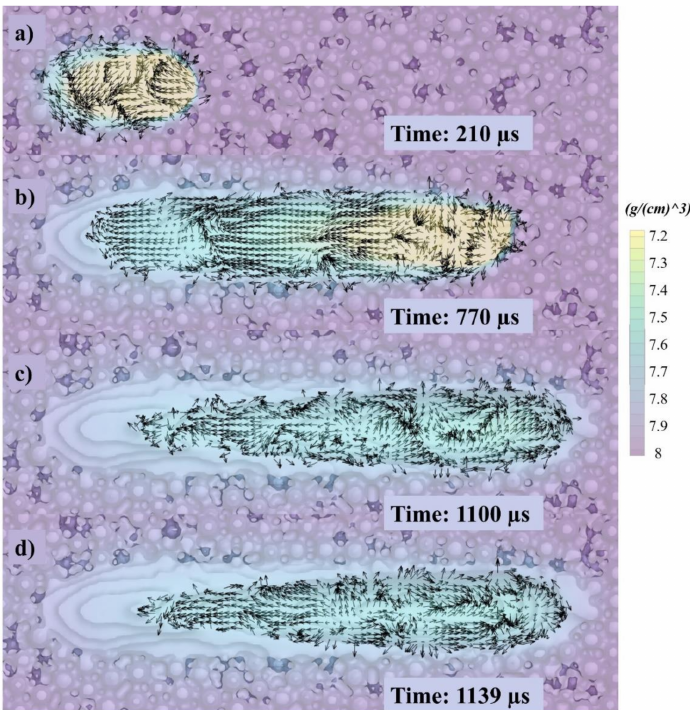
Figure 10. Top-view velocity vectors of single track at ( a ) 210, ( b ) 770, ( c ) 1100, and ( d ) 1139 µ s.